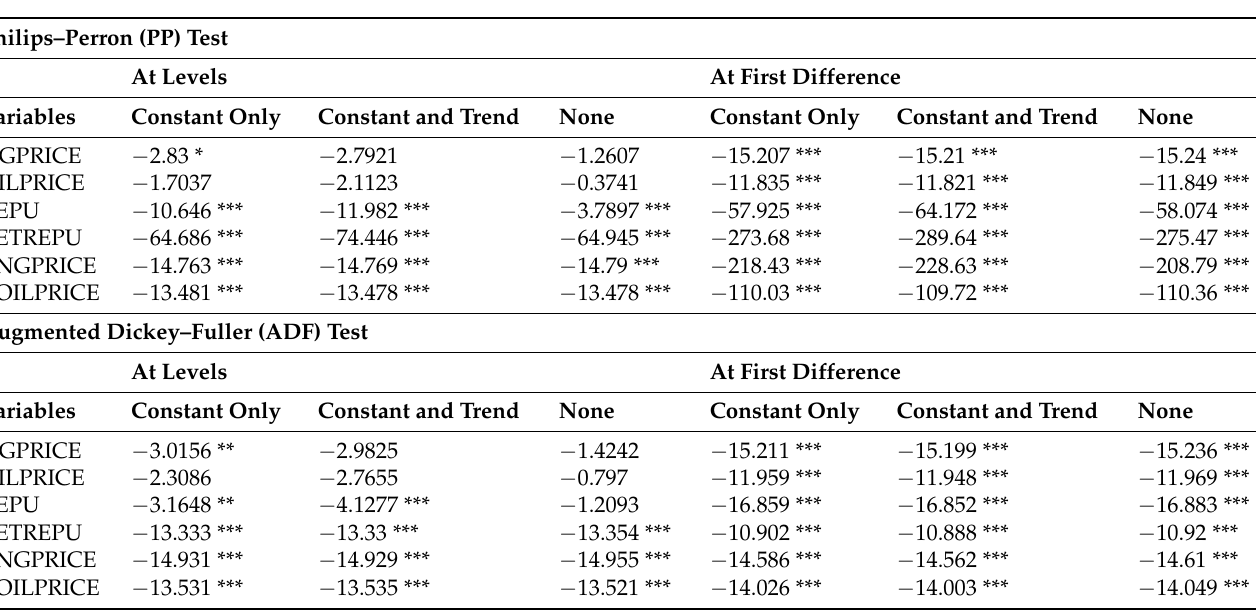
Table 2. Results of unit root